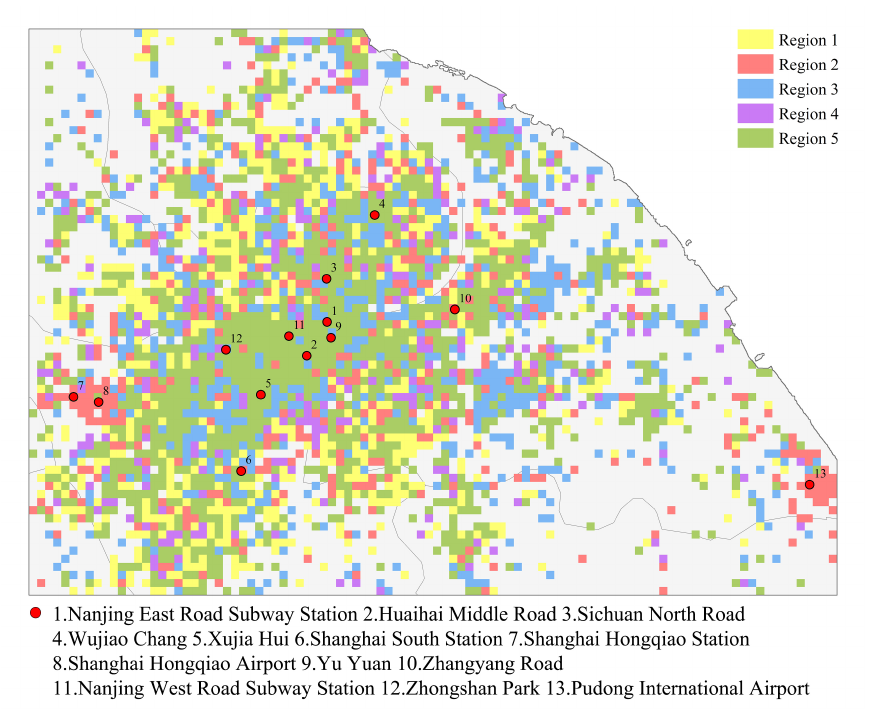
Figure 4. Geographical distribution of functional regions (five detected functional regions are rendered in different colors, and the numbered red dots are points of interest (POI) in Shanghai).